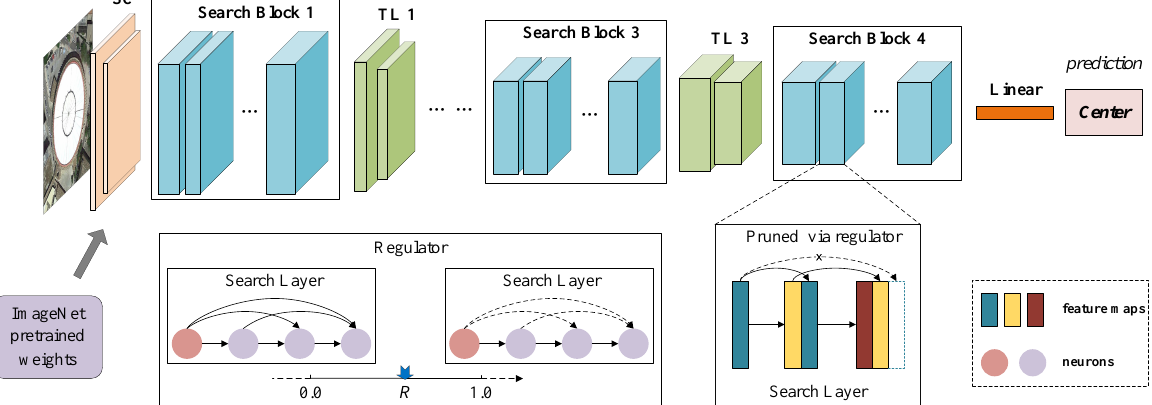
Figure 2. The whole pipeline of the proposed PDN model and the diagram of regulator. SC means Stem Convolution and TL means Transition Layer. Here, we omit some architectures of PDN just for convenience. In PDN model, the sparsity of Search Blocks is adjusted through a regulator. The value of regulator R is closer to 0.0, Search Blocks are more complex. On the contrary, Search Blocks are sparser when R is closer to 1.0. All Search Blocks are controlled by this regulator while Stem Convolution and Transition Layers stay the same. Besides, Linear Layer is consistent with the number of categories. Best view in